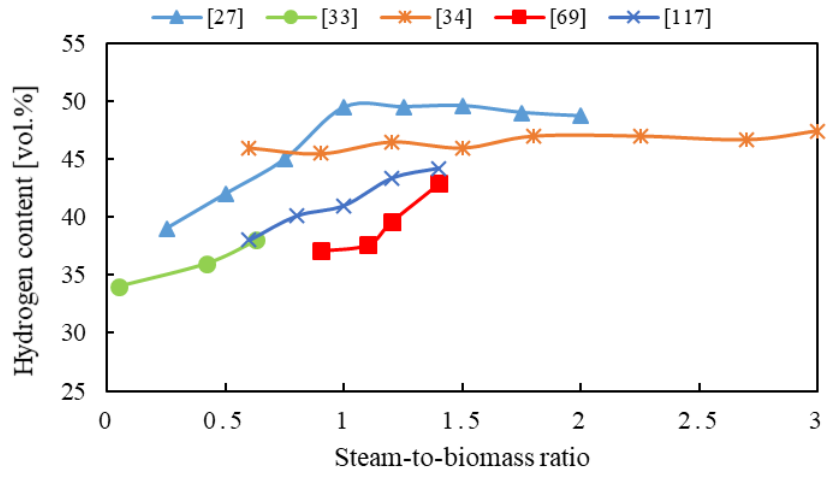
Figure 11. Hydrogen concentration as a function of steam-to-biomass ratio.